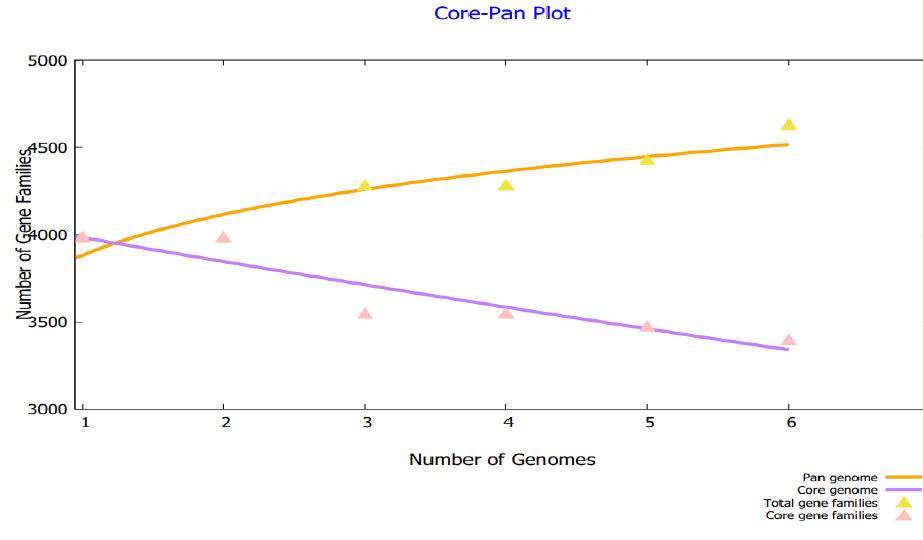
Figure 2. Core pan plot of H. alvei strains.